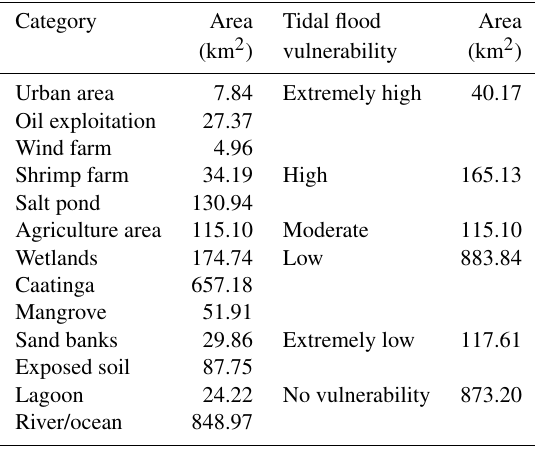
Table 5. Area of land cover and land use categories. Table 6. Area of tidal flood risk in study